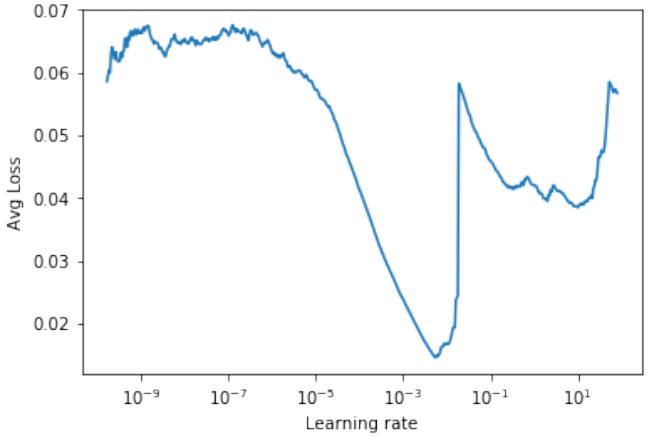
Figure 3. Average training loss against varying learning rates.